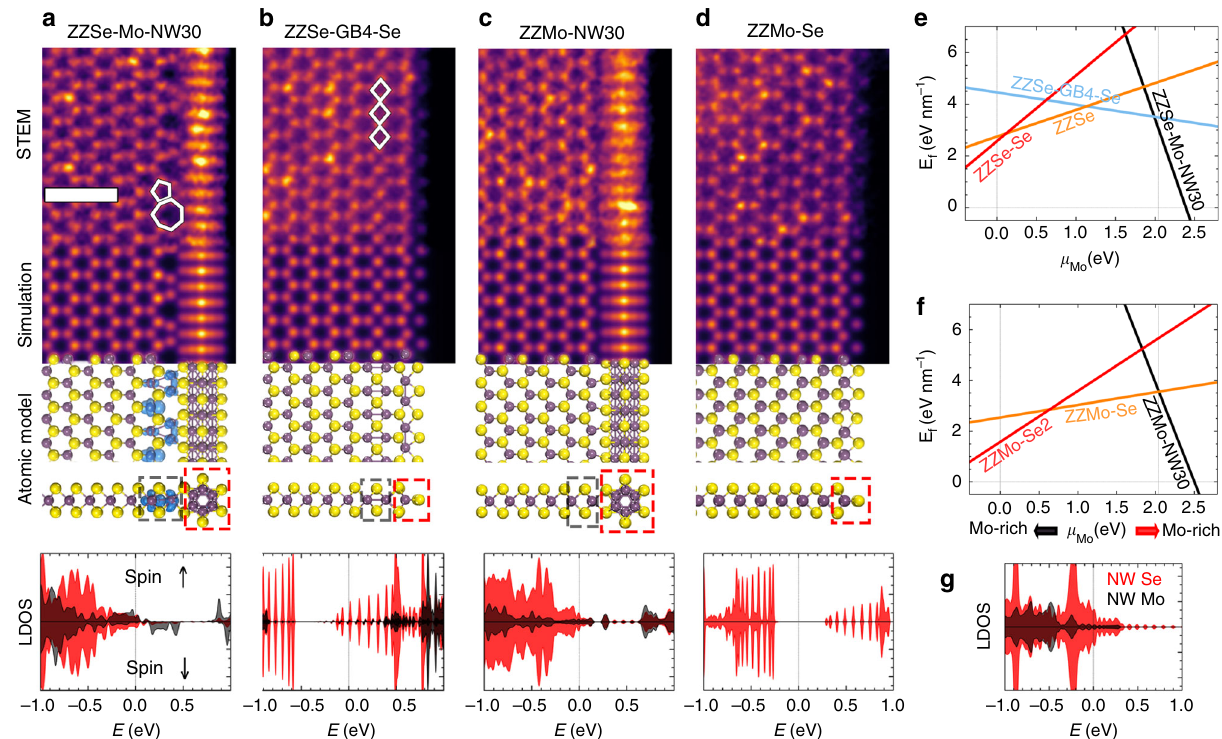
Fig. 2 Analyses of stable edge structures formed during in situ heating. a – d Experimental (the 1st row) and simulated (the 2nd row) HAADF-STEM images, as well as corresponding atomic models (the 3rd row) and local density of states (LDOS) with arbitrary unit (the 4th row) of ZZSe-Mo-NW30 ( a ), ZZSe- GB4-Se ( b ), ZZMo-NW30 ( c ), and ZZMo-Se ( d ) edges, respectively. Fermi energy in LDOS is set to be 0. Red and black LDOS plots are calculated from atoms framed by red and black dashed boxes, respectively. The isosurfaces (highlighted by blue surfaces) of 0.01 e /Å 3 spin-magnetization density ( Δρ = ρ ↑ ‒ ρ ↓ = 0.01 e /Å 3 ) are overlaid on the atomic structure of ZZSe-Mo-NW30 in a . The other three edges have negligible spin-magnetization. Scale bar corresponds to 1 nm. e , f , DFT-calculated formation energy per unit length ( E f ) as a function of the Mo chemical potential, µ Mo , for four Se-oriented (ZZSe) edges ( e ) and three Mo-oriented (ZZMo) edges ( f ). The two vertical dashed lines denote the range 0 eV < µ Mo < 2.04eV, where MoSe 2 can remain stable with respect to the formation of bulk Mo ( µ Mo = 2.04 eV) or bulk α -Se ( µ Mo = 0 eV). g LDOS of freestanding MoSe NW contributed by Mo (black) and Se (red)